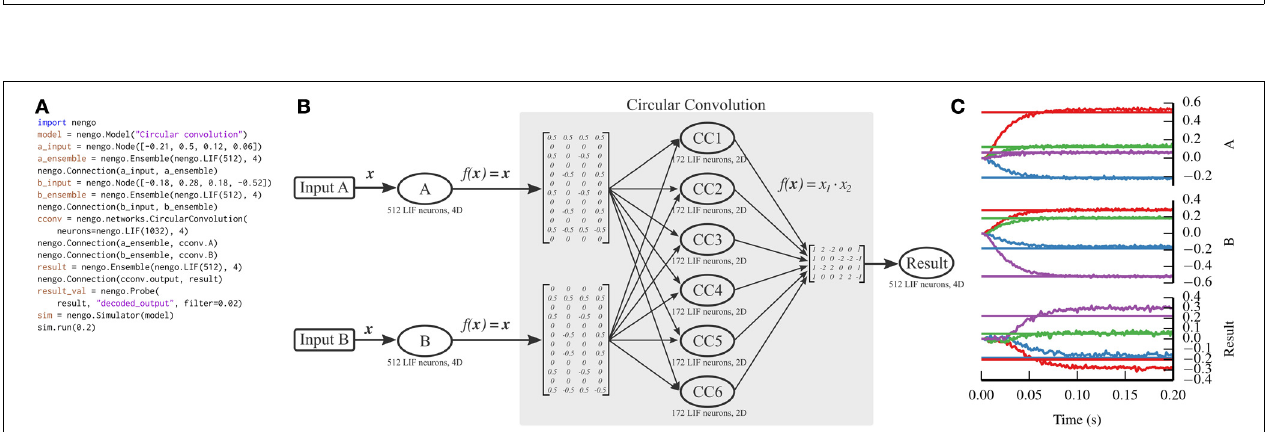
ensemble. (C) The trajectory that the state ensemble takes in its three-dimensional state space. For the parameters chosen, the trajectory takes the well-known butterfly shape. (D) The state vector plotted over time. (E) The spikes emitted by a random sample of 25 neurons from the state ensemble. Some neurons fire uniformly across the 6s simulation, but most change depending on the state being tracked due to the recurrent connection.